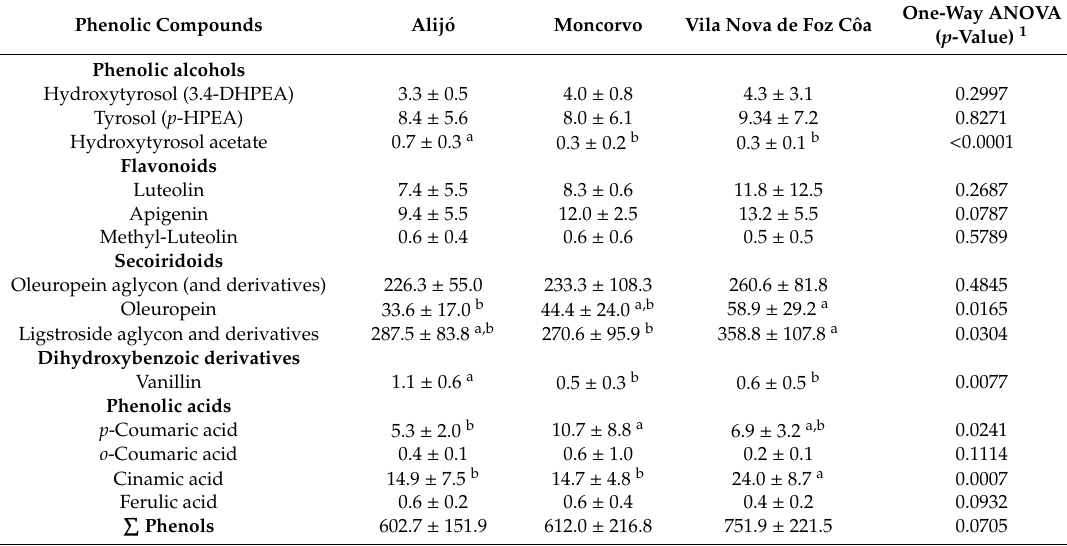
Table 5. Phenolic composition (mg / kg of oil) of oils extracted from oleaster (mean ± standard deviation) collected from di ff erent geographical locations (Alij ó . Moncorvo and Vila Nova de Foz C ô a). Di ff erent lower case letters mean significant statistical di ff erences at a 5% significance level (one-way ANOVA followed by the Tukey’s multi-comparison